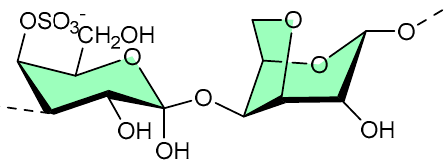
Figure 7. Available site for material functionalization on κ -carrageenan structure.